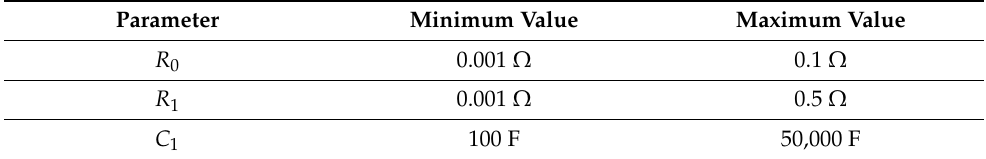
Table 3. Battery system physical boundaries.